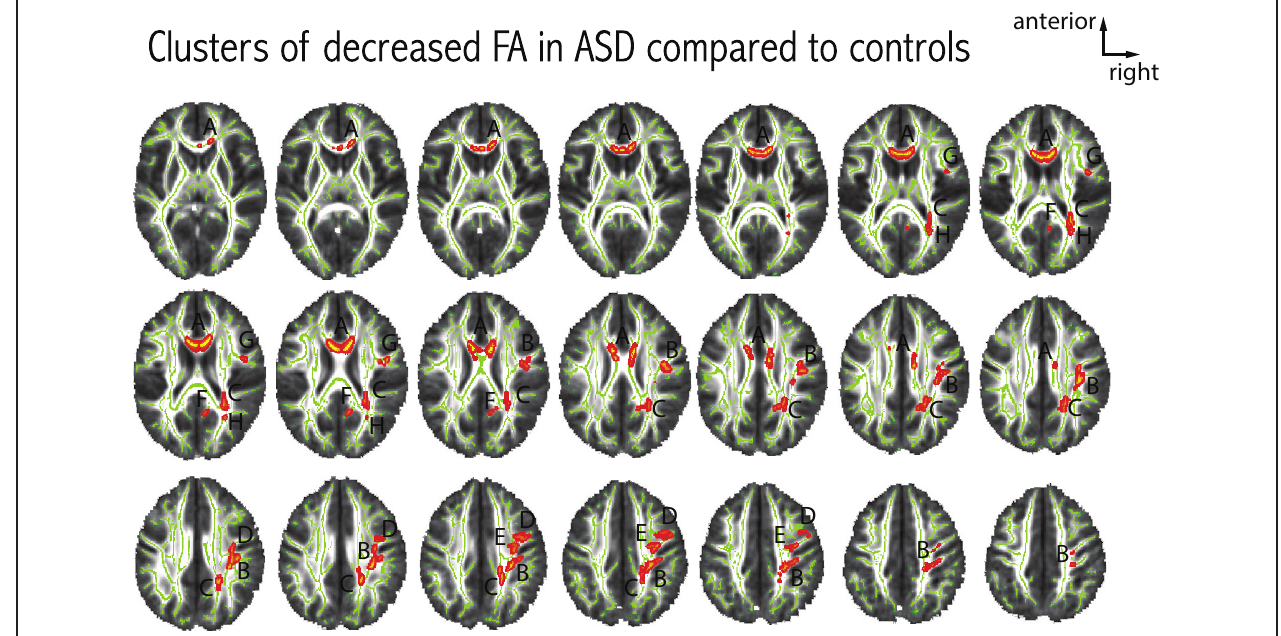
z = 104 (725 voxels); C: x = 66, y = 78, z = 101 (470 voxels); D: x = 57, y = 106, z = 129 (186 voxels); E: x = 46, y = 131, z = 112 (137 voxels); F: x = 82, y = 70, z = 93 (70 voxels); G: x = 43, y = 128, z = 90 (42 voxels); H: x = 60, y = 65, z = 88 (23 voxels). We did not observe any clusters with increased FA in patients with ASD compared to